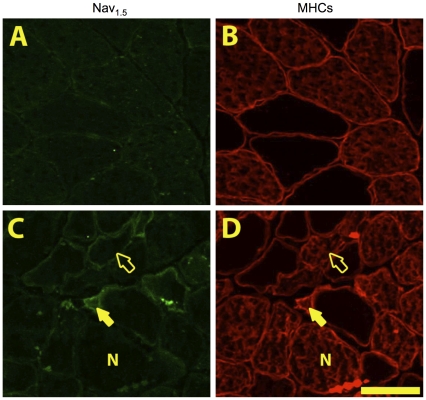
Alterations in myofiber Nav1.5 expression with aging.Photomicrographs of serial sections of the red region of gastrocnemius muscle labeled for Nav1.5 (A,C) and MHC slow (B,D) in young adult (A,B) and senescent (C,D) rats. In senescent muscle we saw three classes of Nav1.5 labelling; negative (N), ringed (displaying circumferential labelling, open arrowhead) and cytoplasm (showing cytoplasmic staining, shaded arrowhead). Scale bar is 50 µm.